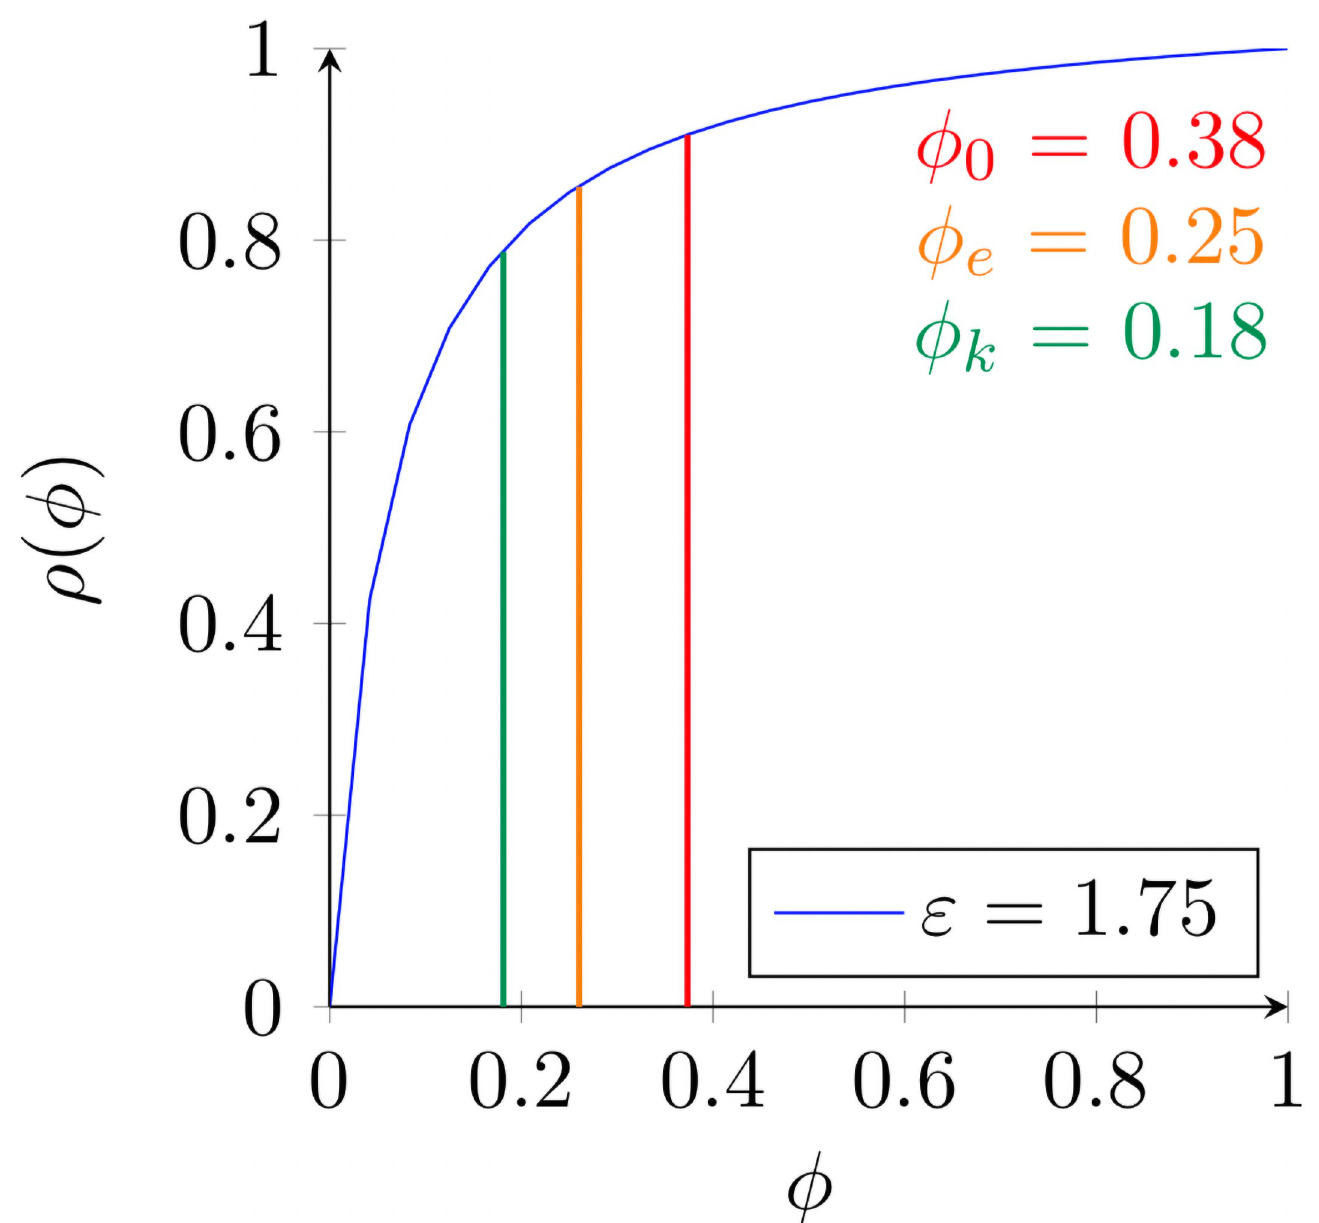
Fig 1. Example illustration of ϕ 0 , ϕ